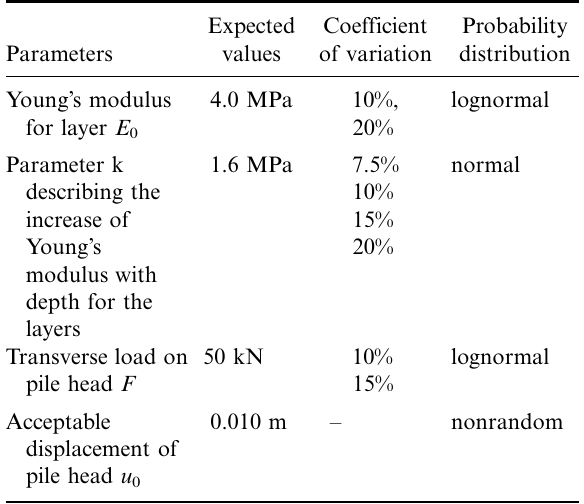
Table 3. Characteristics of variables involved in the